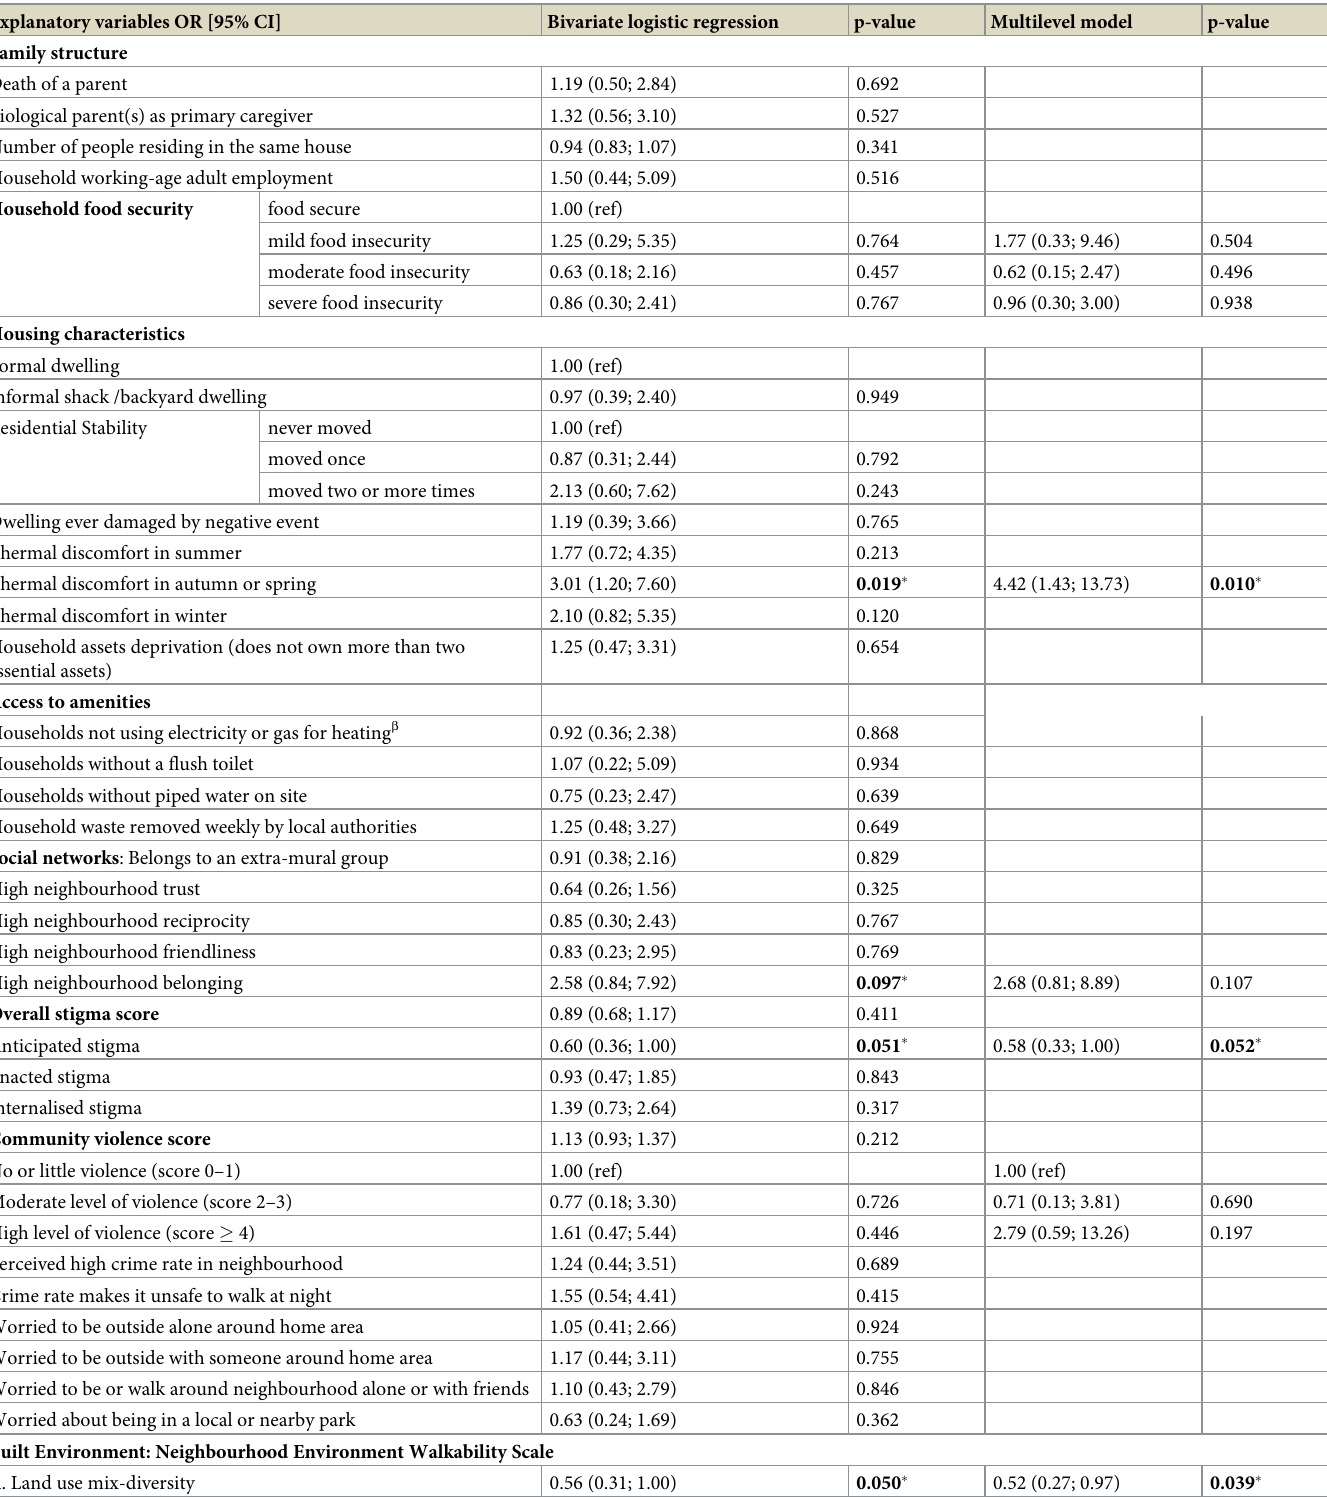
Table 5. Bivariate and multivariate associations between household, community, built and food environment factors and abdominal